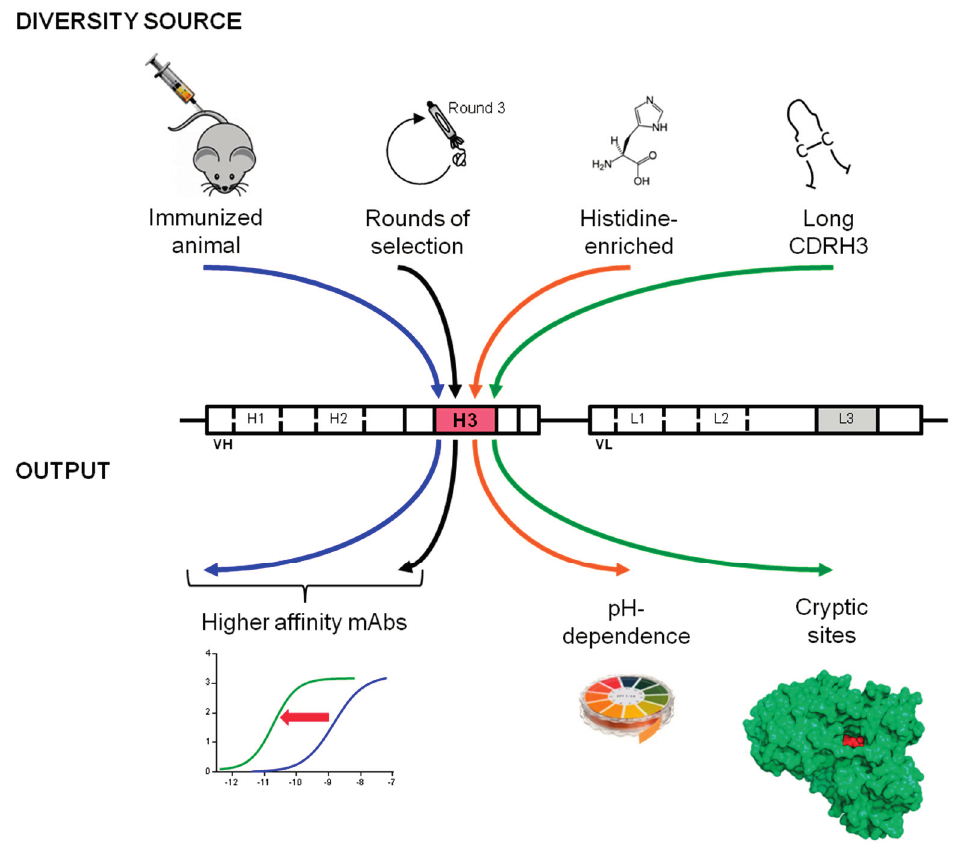
Figure 6. Creation of purpose-oriented libraries by the introduction of tailor-made diversity into the CDRH3. A straightforward cloning strategy can be used to capture CDRH3 sequences with selected characteristics for the construction of libraries for different purposes. Several examples reported in this and previous studies are schematically depicted. In order to obtain higher affinities, libraries can incorporate antigen-biased CDRH3 sequences that are enriched in vivo or in vitro for antigen specificity [18]. The introduction of synthetic diversity biased either on amino acid content or length enables the efficient isolation of pH-dependent and enzyme neutralizing